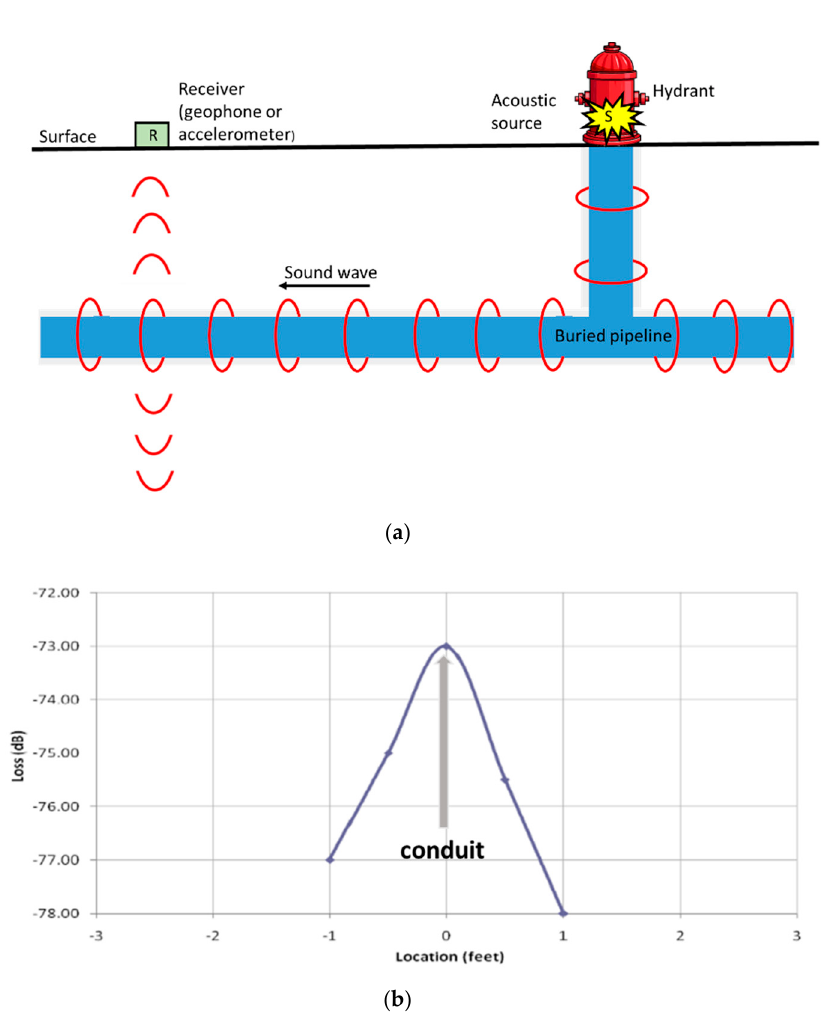
Figure 5. Traditional acoustic transmission method: ( a ) principle of the method, modified from [9]; ( b ) response versus location for conduit (directly excited) [11].